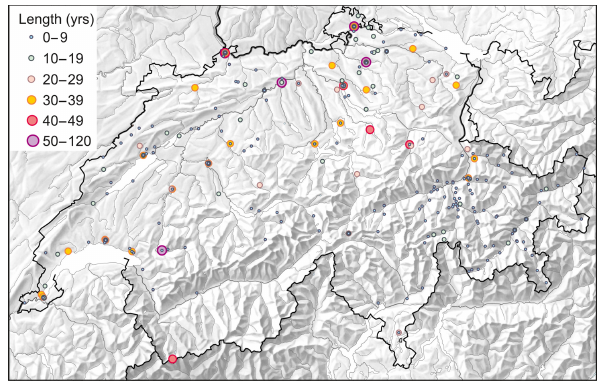
Figure 3. Map of the available stations in Switzerland before 1864 showing the length of the